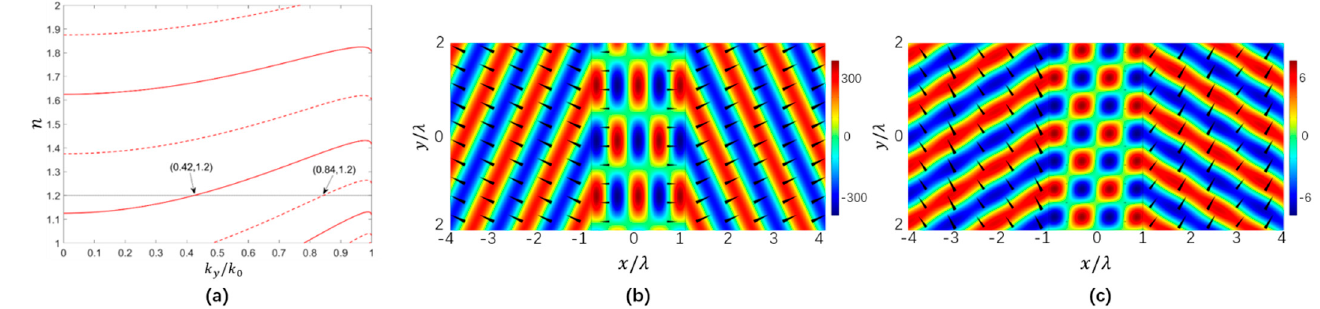
Figure 2. ( a ) The dispersion relation of the laser mode with the red solid and dashed curves corre- spond to the even and odd modes, respectively. ( b ) The acoustic pressure field distribution for the even mode with an incident pressure amplitude of 1.0 Pa and an angle of θ = 25.12 0 incident from the left. ( c ) The acoustic pressure field distribution for the odd mode with an incident pressure amplitude of 1.0 Pa and an angle of θ = 57.58 0 incident from the left.